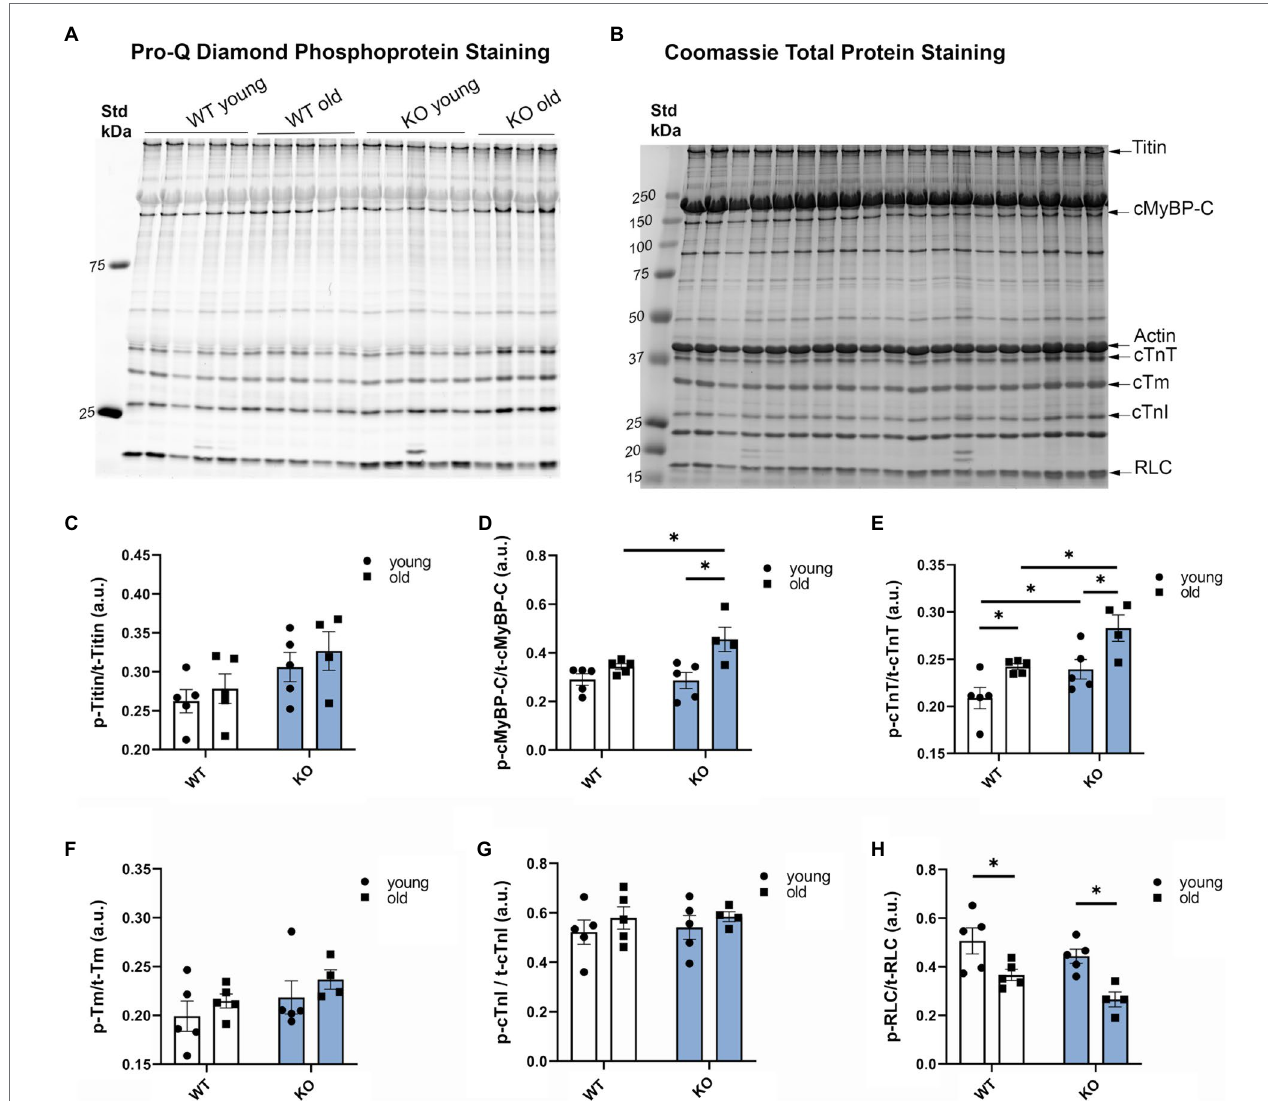
FIGURE 3 | Deletion of β -arrestin-2 alters the phosphorylation of myofilament proteins. (A) Pro-Q Diamond staining of phosphorylated myofilament proteins on 15% SDS-PAGE gel. (B) Coomassie staining of total protein of the corresponding bands on the same gel. (C) Quantification of phosphorylated titin, (D) cardiac myosin binding protein-C (cMyBP-C), (E) cardiac troponin T, (F) cardiac tropomyosin (cTm), (G) cardiac troponin I (cTnI), and (H) regulatory light chain (RLC) in arbitrary units (a.u.). Young: 3–6 months and old: 12–16 months. N = 4–5. Data presented as mean ± SEM. Outliers were identified with the ROUT method and excluded from analyses. Data analyzed with a two-way ANOVA post-hoc Fisher’s LSD test. * p <